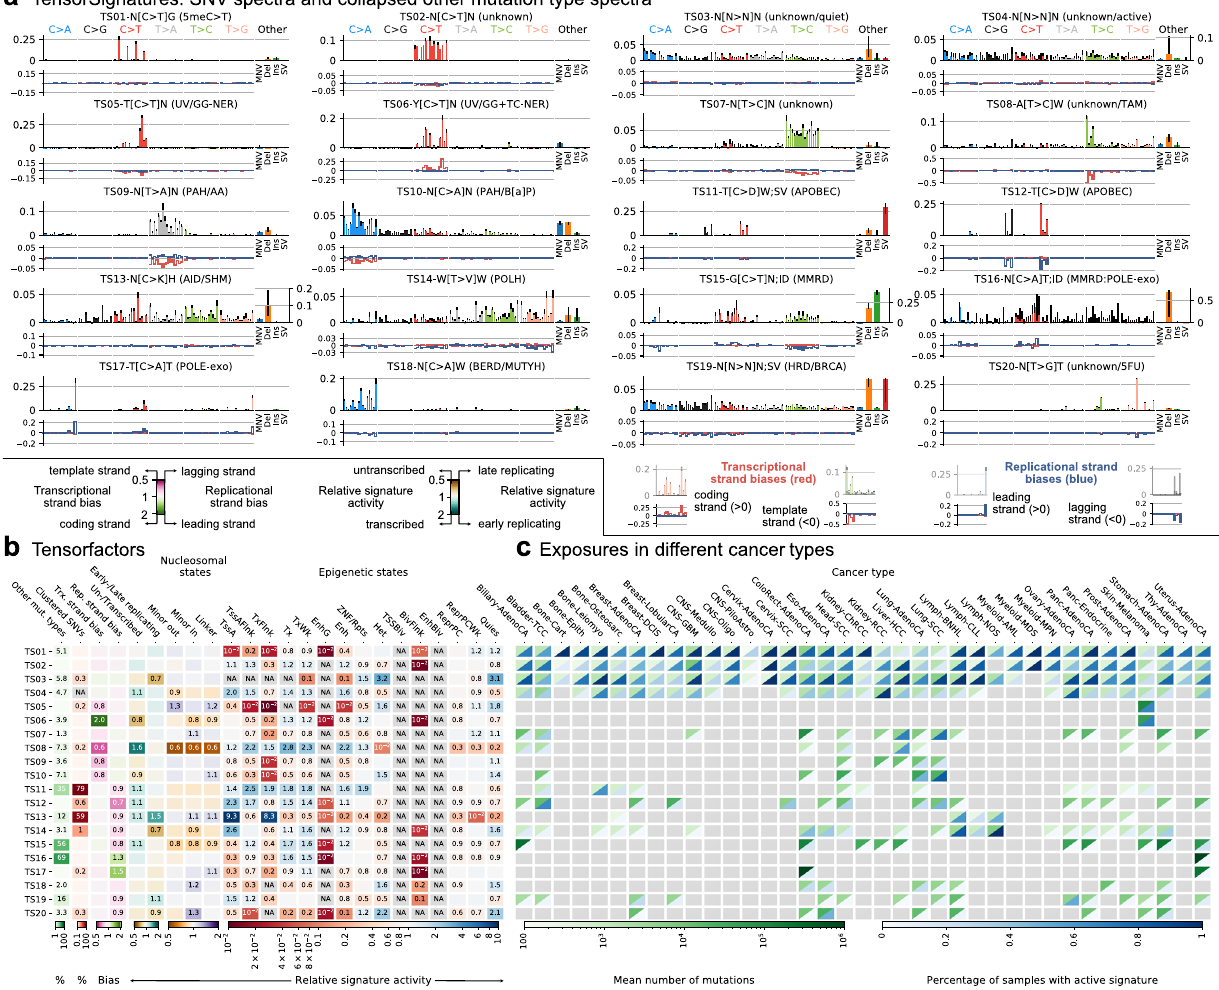
Fig. 2 Applying TensorSignatures on 2778 whole genomes from the ICCG PCAWG consortium revealed 20 tensor signatures and their genomic properties. a Upper panels depict SNV spectra, and a summarised representation of associated other mutation types (error bars determine 95% bootstrap con fi dence intervals). SNV mutations are shown according to the conventional 96 single base substitution classi fi cation based on mutation type in a pyrimidine context (blue C > A, black C > G, red C > T, green T > A, grey T > C, salmon T > G) and 5' and 3' fl anking bases (in alphabetical order). The panel under each SNV spectrum indicates transcriptional (red), and replicational strand biases (blue) for each mutation type, in which negative deviations indicate a higher probability for template or lagging strand pyrimidine mutations, and positive amplitudes a larger likelihood for coding or lagging strand pyrimidine mutations (and vice versa for purine mutations). b Heatmap visualisation of extracted tensor factors describing the genomic properties of each tensor signature. Proportions of other mutation types and clustered SNVs are indicated in percentages. Transcriptional and replicational strand biases indicate shifts in the distribution of pyrimidine mutations on coding/template and leading/lagging strand. Coef fi cients < 1 (pink) indicate signature enrichment on template or lagging strand DNA, and conversely values > 1 (green), a larger mutational burden on coding or leading strand (a value of 1 indicates no transcriptional or replicational bias). Relative signature activities in transcribed/untranscribed and early/late replicating regions. Coef fi cients > 1 (turquoise) indicate enrichment in transcribed and early replicating regions, while values < 1 (brown) indicate a stronger activity of the mutational process in untranscribed or late replicating regions. Relative signature activities on nucleosomes and linker regions, and across epigenetic states as de fi ned by consensus ChromHMM states. Scores indicate relative signature activity in comparison to genomic baseline activity. A value of 1 means no increase or decrease of a signature ’ s activity in the particular genomic state, while values > 1 indicate a higher, and values < 1 imply a decreased activity. c Signature activity in different cancer types (Exposures). Upper triangles (green) indicate the mean number of mutations contributed by each signature, lower triangles show the percentage of samples with a detectable signal of signature de fi ned as the number of mutations attributed to the signature falling into a signature-speci fi c typical range (Methods). Greyed boxes indicate cancer types for which a signature was not found to contribute meaningfully. Source data are provided as a Source Data fi